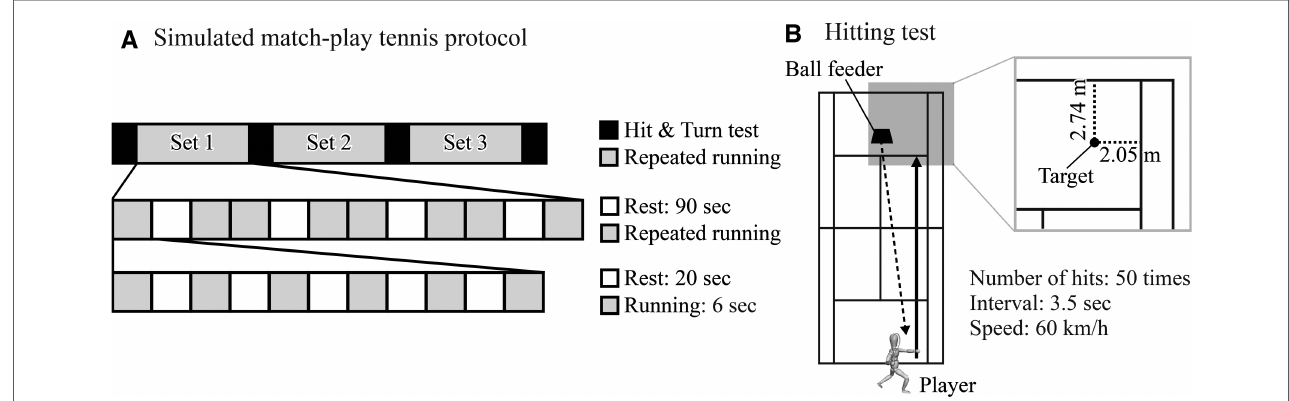
FIGURE 1 Overview of simulated match-play tennis protocol and hitting test. ( A ) Time structure of exercise and rest in the simulated match-play tennis protocol. From top to bottom, the structure of a match (3 sets), a set (8 games), and a game (5 points) are shown. The hitting test is shown in black, running in gray, and rest in white. ( B ) Overview of the hitting test. The target was set at 2.74 m from the baseline and 2.05 m from the singles line on the advantage